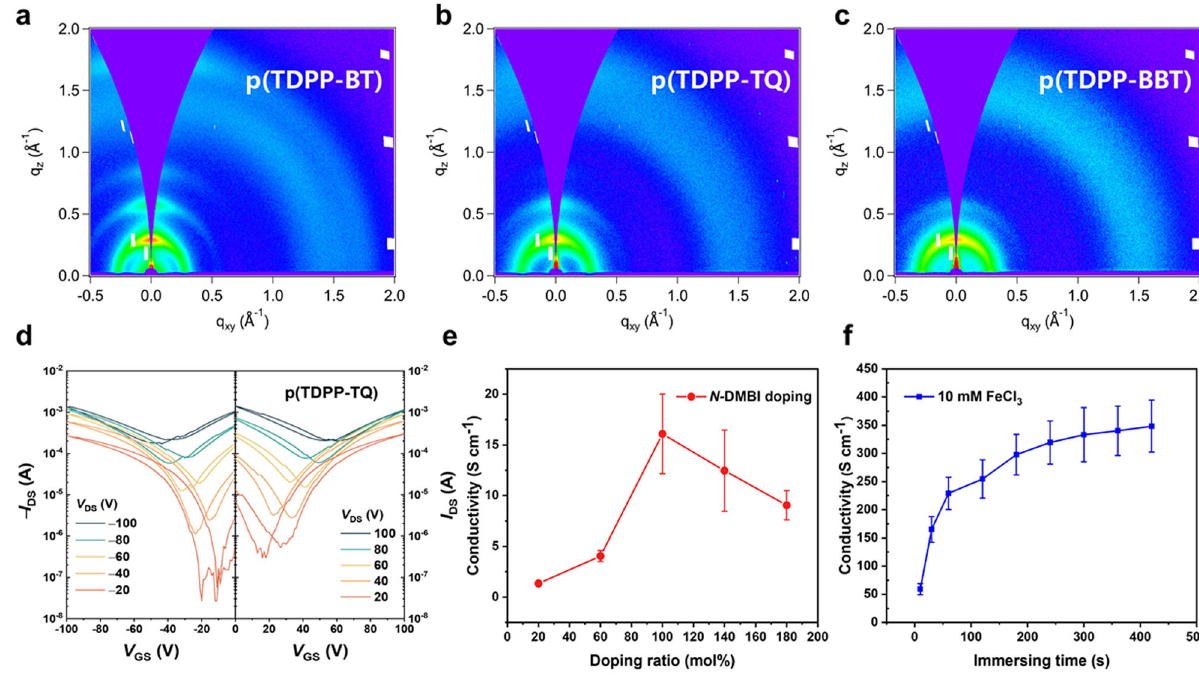
Fig. 6 Thin fi lm morphology and device characterization. 2D-grazing incidence wide-angle X-ray scattering (GIWAXS) pattern of a p(TDPP-BT), b p(TDPP-TQ), c p(TDPP-BBT). d Typical transfer characteristics of a p(TDPP-TQ) FET device. e N-type electrical conductivities of p(TDPP-TQ) doped by N -DMBI with different ratios; f P-type electrical conductivities of p(TDPP-TQ) doped by immersing in 10 mM FeCl 3 solution. Error bars indicate the standard deviation of ten experimental